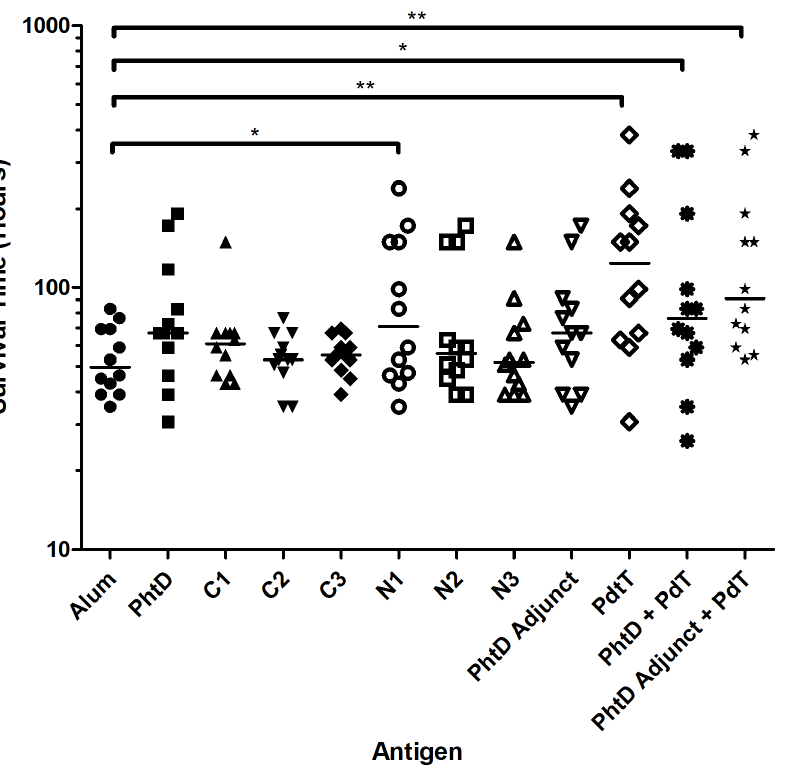
Figure 8. Survival times of mice challenged with P9 after immunisation with the indicated antigens. Median survival times are indicated by horizontal lines. Significant differences from the alum only control group are indicated where present (*, P , 0.05; **, P , 0.01).